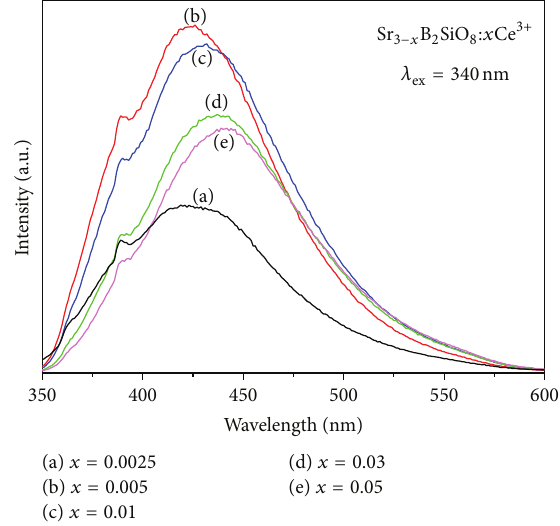
Figure 3: Photoluminescence emission spectra of Sr 3−𝑥 B 2 SiO 8 : 𝑥 Ce 3+ with different Ce 3+ concentration under the excitation of 340